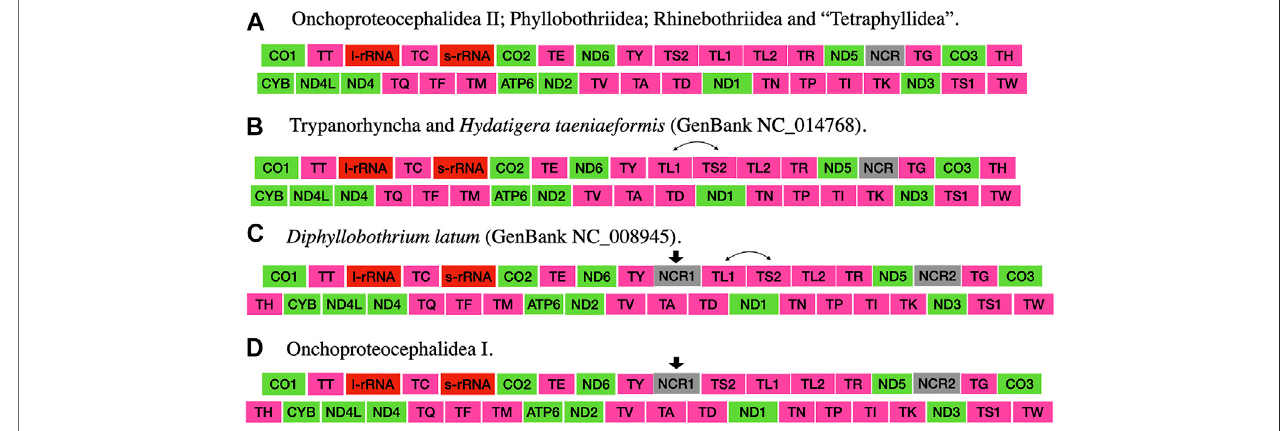
FIGURE 2 | Gene order of the mitogenomes presented in this study and those cited in the discussion section (taken from Li et al., 2017). Arrows indicate the acquisition of a feature. Double-headed arrows indicate the swap of two features.